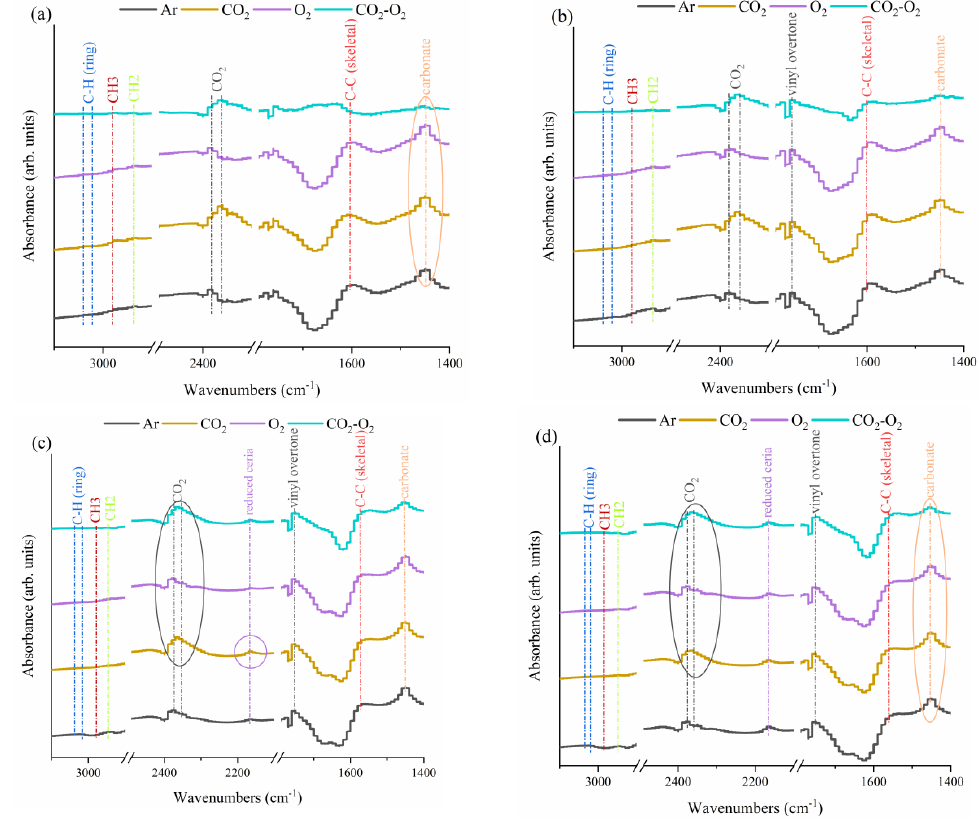
Figure 12. In situ IR spectra of the programmed warming of ethylbenzene over the 10%K/CeO 2 catalyst under different atmospheres. ( a ) 100 °C; ( b ) 200 °C; ( c ) 400 °C; ( d ) 500 °C. Experimental conditions: a warming rate 10 °C/min, an adsorption temperature of 100 °C, an adsorption time of 30 min, purge gas Ar, purge flow rate 25 mL/min, four atmospheres: pure Ar, CO 2 , 4O 2 , CO 2 -4O 2 , and the 10%K/CeO 2 catalyst, respectively.